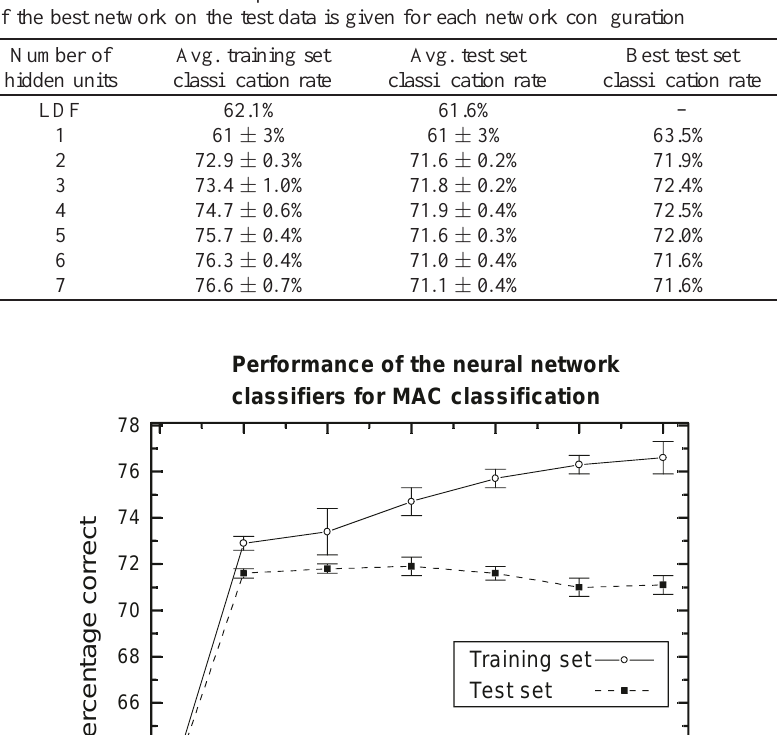
Table 2 The average correct classification rate and standard deviations for 20 randomly ini-